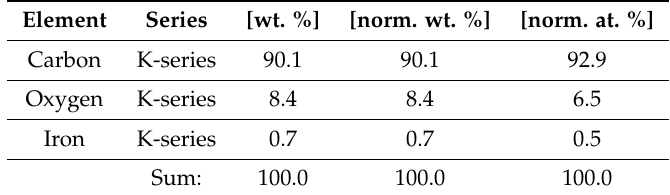
Table 2. Energy dispersive X-ray spectroscopy (EDX) mapping data for multiwalled carbon nanotubes (MWCNT).